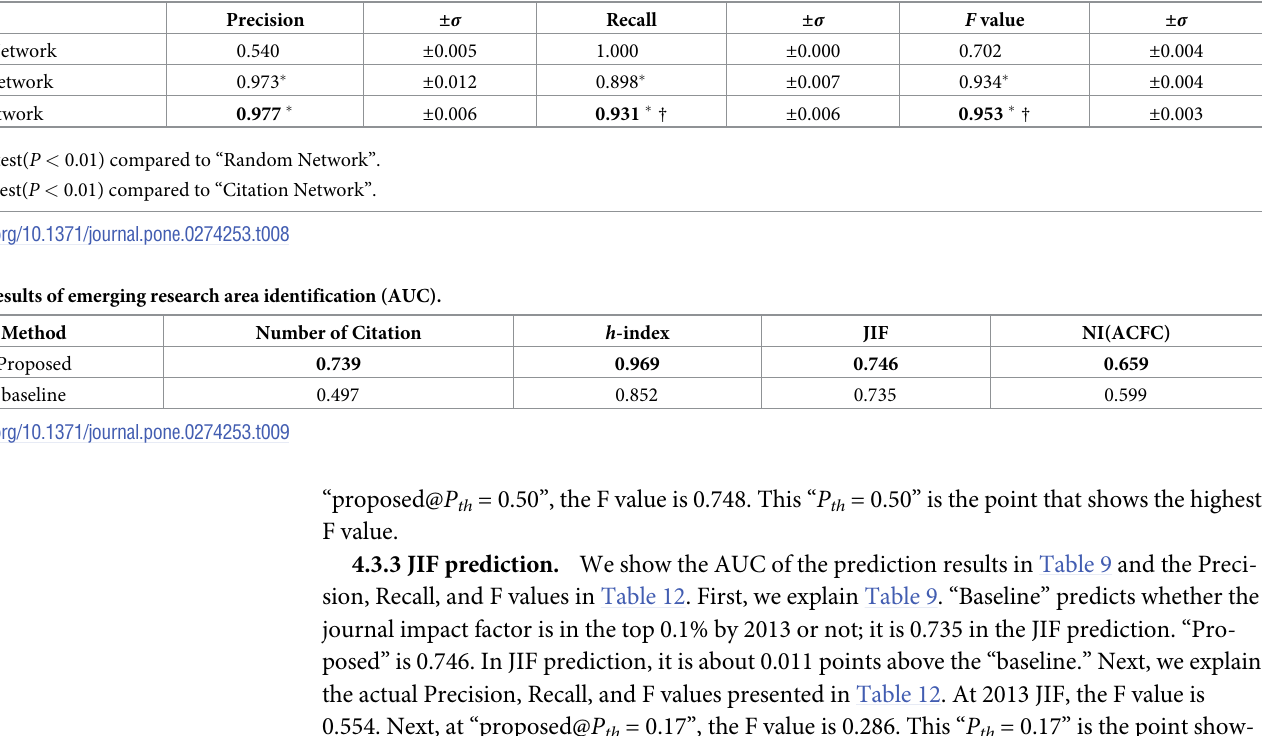
Table 8. Comparison results of link prediction by distributed representation obtained from first-order connection.